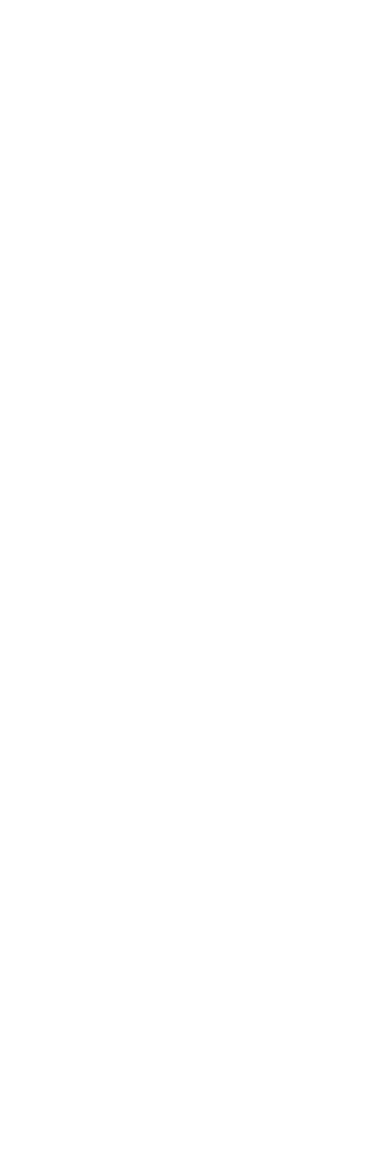
FIGURE 11 Diagnosis results showing the CDF of the EDH under different atmospheric strati fi cations: (A) stable and unstable conditions; (B) stable conditions; (C) unstable